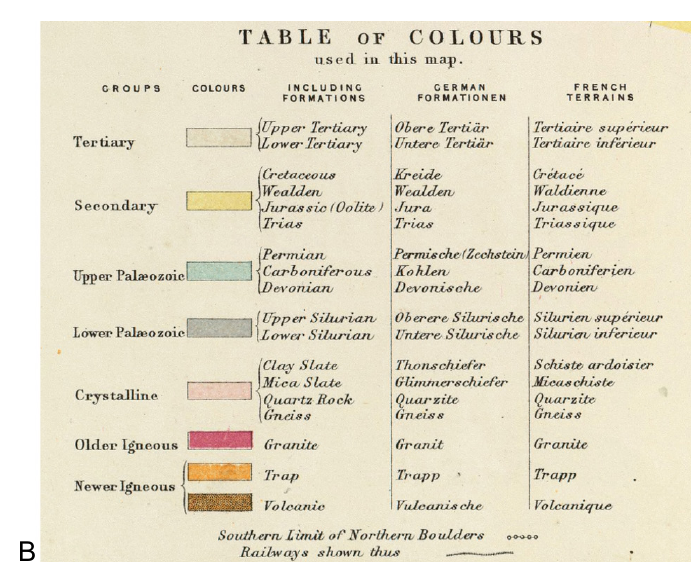
Fig. 10. Part of Geological Map of Europe created by Murchison and Nicol − A and its explanation – B (from the David Rumsey Map